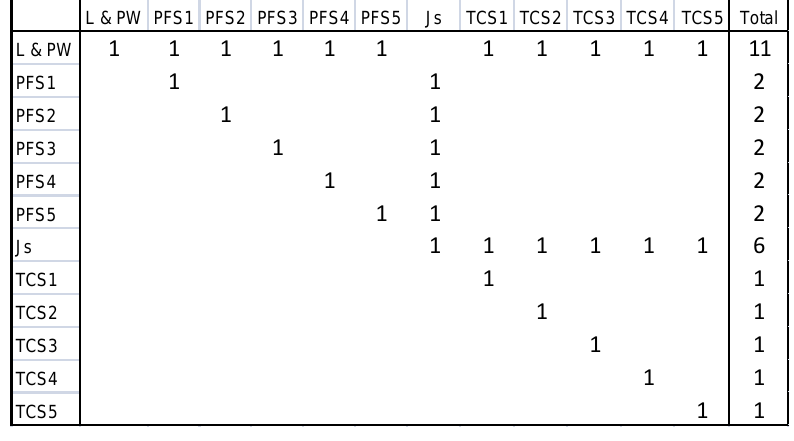
Figure 7. “N2 matrix for CL”. Source: